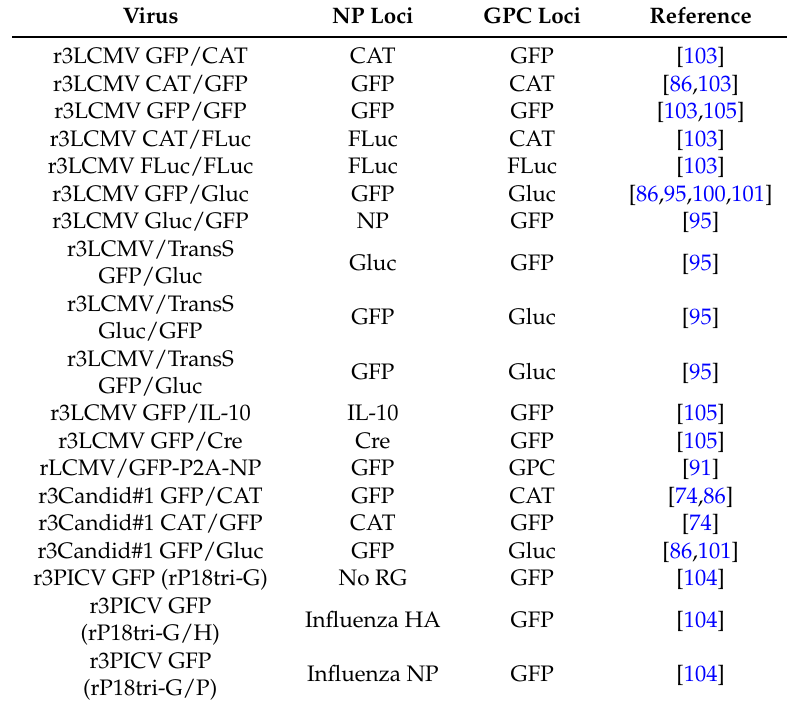
Table 1. Reporter-expressing recombinant